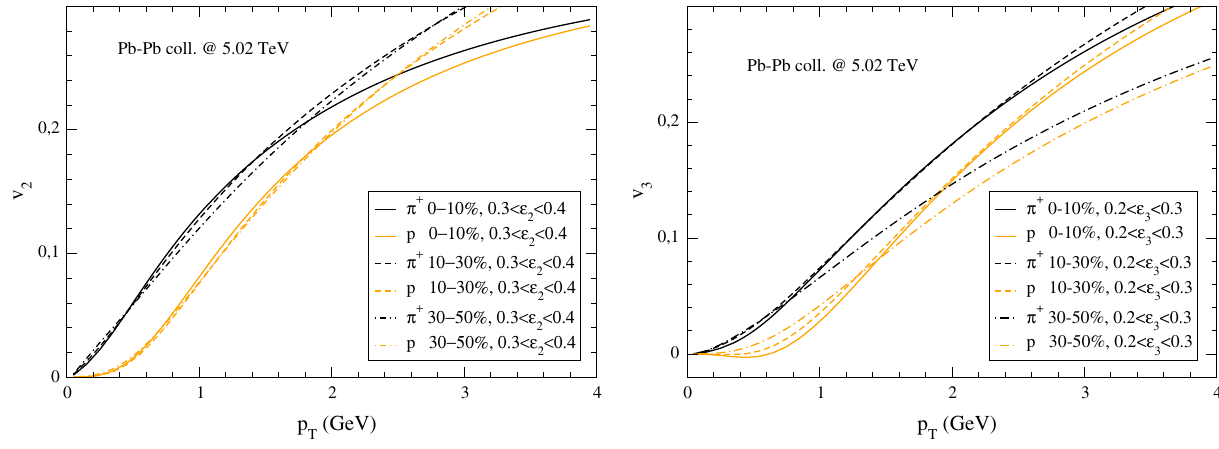
Fig. 9 The elliptic and triangular flow of pions and protons in Pb–Pb √ s NN = 5 . 02 TeV for events characterized by the same collisions at eccentricity (0 . 3 ≤ (cid:7) 2 ≤ 0 . 4 and 0 . 2 ≤ (cid:7) 3 ≤ 0 . 3) but belonging to